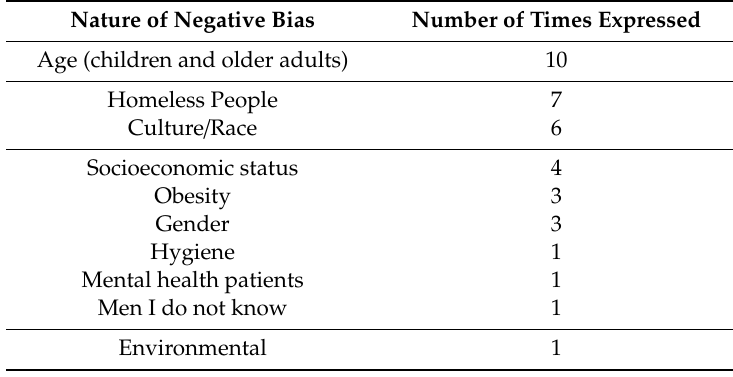
Table 2. Summary of written statements of prejudices expressed by students in a survey regarding the biases of which they became aware in their team service-learning experiences (30 of 32 students stated one or more of their